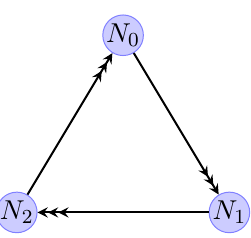
Figure 1. The quiver of the C 3 = Z 3 orbifold theory with k I = (1 ; 1 ; 1). The bifundamental (cid:12)elds are arrows connecting nodes representing U( N ) gauge groups. The condition of anomaly cancellation gives N 0 = N 1 = N 2 and, as a result, (cid:12) 0 = (cid:12) 1 = (cid:12) 2 =